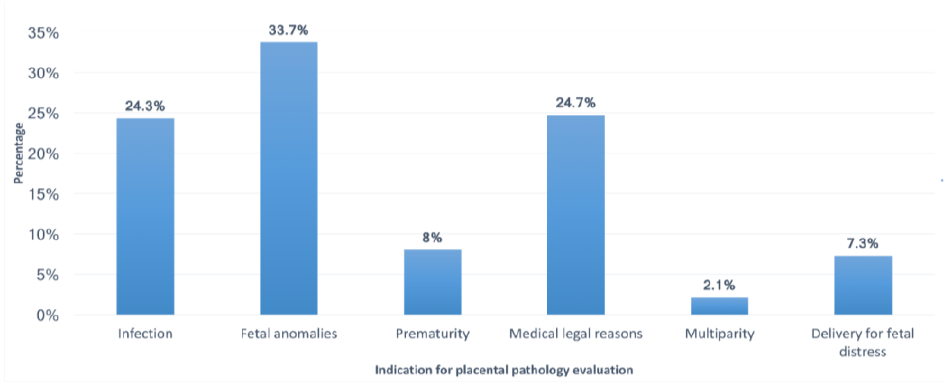
Figure 1. Indications for pathological examination of placentas when the CAP guidelines were not used. not used.